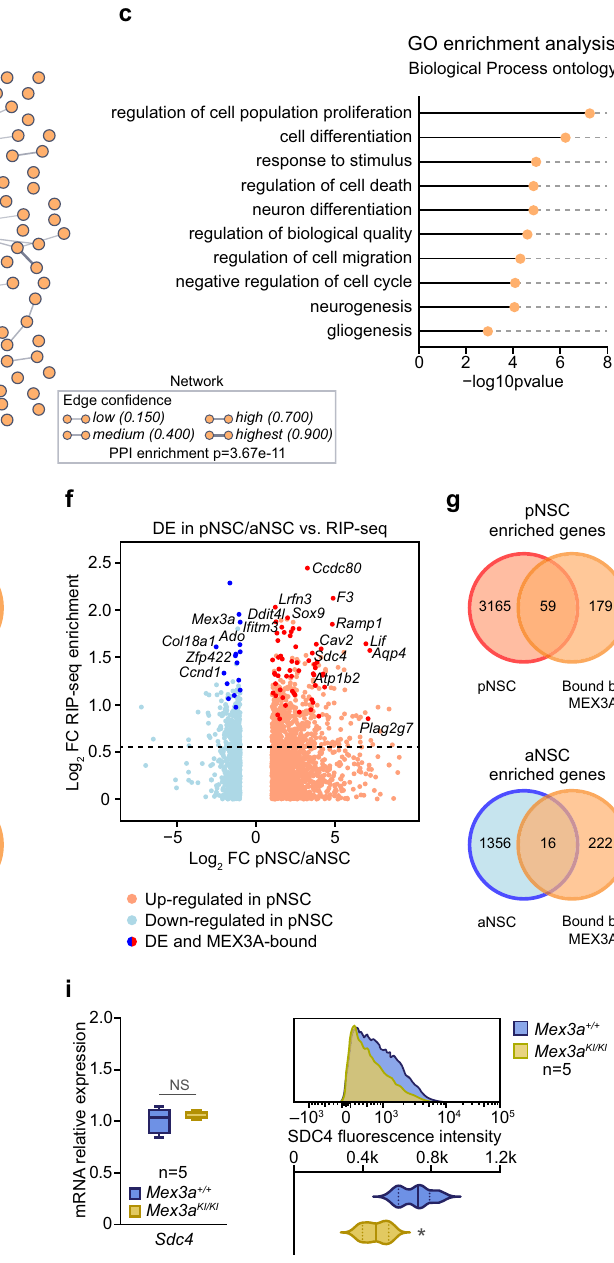
Fig. 3 | The MEX3A regulon reveals a stemness/gliogenic program associated with neurogenic lineage quality. a MEX3A RNA-immunoprecipitation (RIP) dia- gram. IP: immunoprecipitation; C: crosslinked samples; NC: non-crosslinked sam- ples. b Protein-protein interaction network generated from MEX3A-bound coding RNAs (STRING PPI enrichment p -value=3.67×10 − 11 ). Line thickness indicates strength and con fi dence of the connection (https://string-db.org/). See Supple- mentaryFig.3candSupplementaryData1fordetailedtargetlists. c Representative Gene Ontology (GO, Biological Process) terms enriched in the subset of MEX3A- boundcodingRNAs(seeSupplementaryData2foracompleteGOlist).Signi fi cance values are reported after FDR correction. d Scatterplot comparing differential expression(DE)datafromDFFDA high vs.DFFDA low populations 12 withMEX3ARIP-seq enrichment (FDR<0.05). Red dots represent up-regulated, and blue dots down- regulated genes in DFFDA high cells. Dark red and blue dots label DE genes also bound by MEX3A. e Overlap between MEX3A-bound genes (orange) and genes enriched in DFFDA high (red, top) and DFFDA low (blue, bottom) populations. DFFDA high and MEX3A-bound genes show more overlap than expected ( p -value=